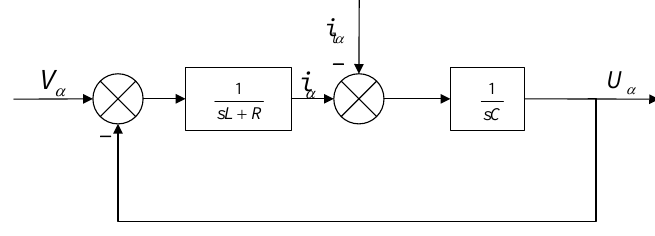
Figure 2. Block diagram of control structure of the three-phase inverter.